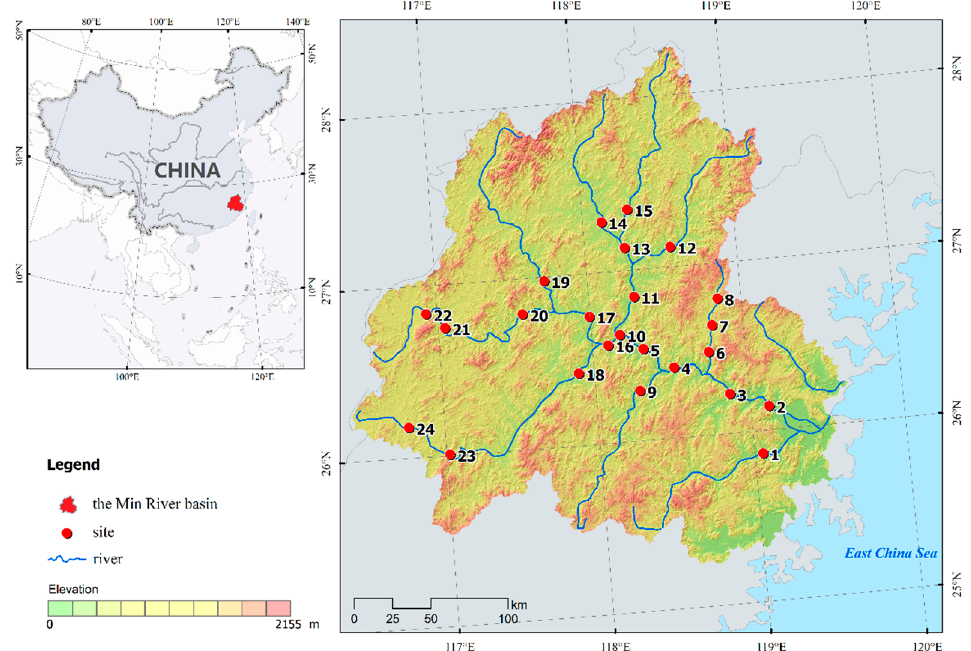
Figure 1. Map of freshwater fish sampling sites in the Min River, the biggest river in Southeastern China.